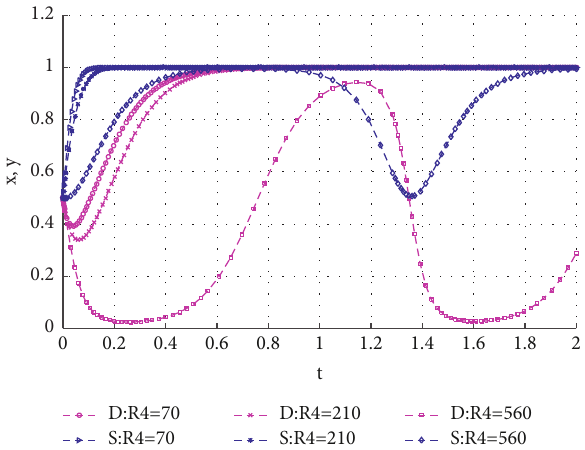
Figure 7: The evolutionary result of the change in the extra income of opportunistic behavior.